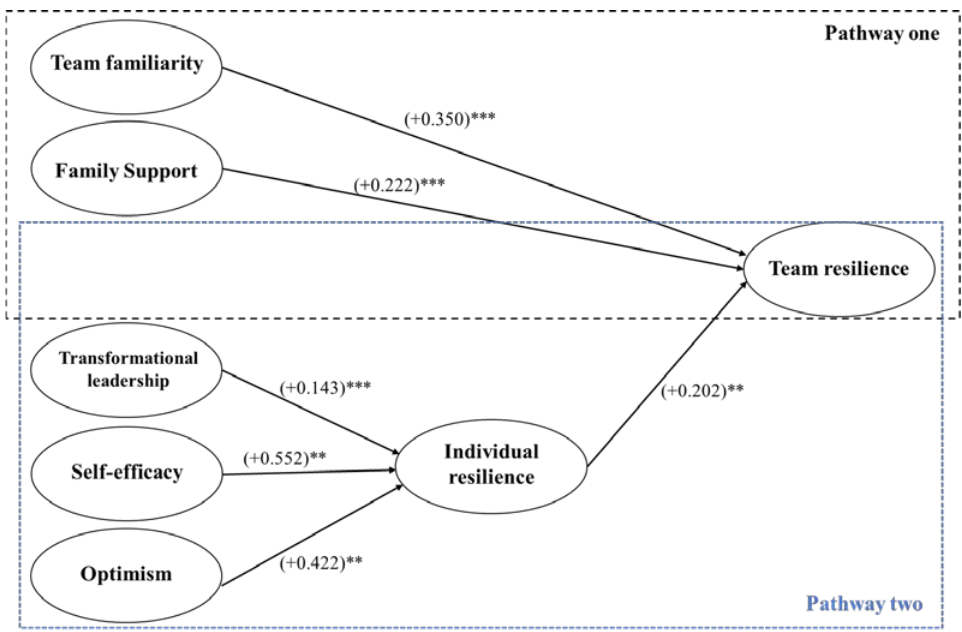
Figure 1. Pathways to team resilience. ** p < 0.010; *** p < 0.001.